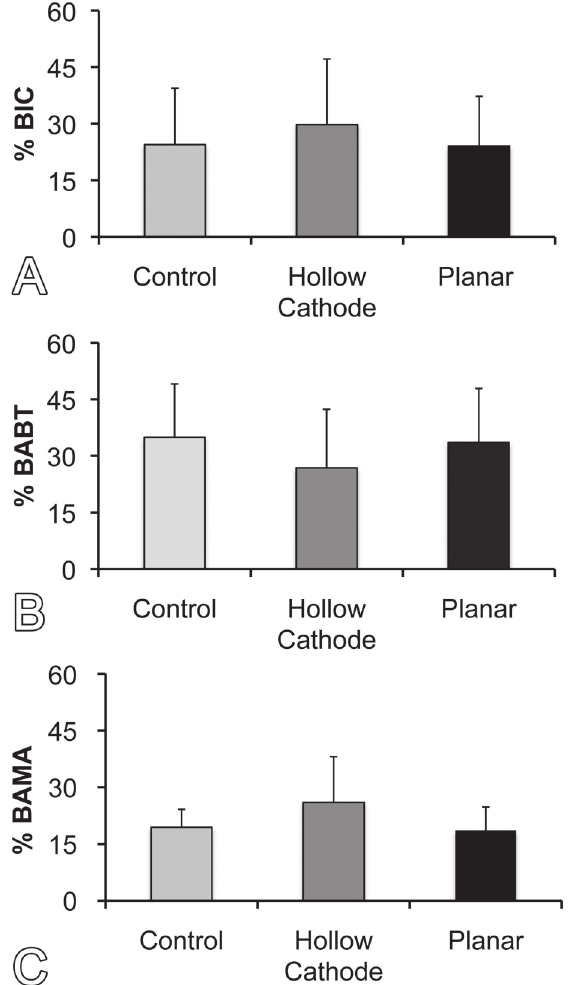
Figure 3- Bone formation around Ti implant surfaces placed into rabbit tibiae at 6 weeks. (A) Bone-to-implant contact (BIC); (B) Mineralized bone area between threads (BABT); (C) Mineralized bone area within mirror area (BAMA). The percentage of BIC, BABT, and BAMA was not affected by surface treatments